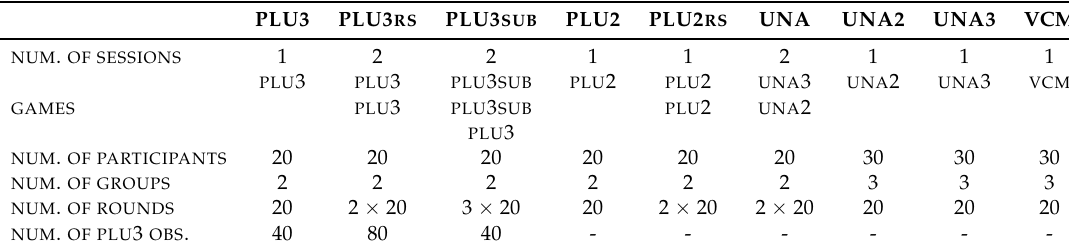
Table 2. Treatments